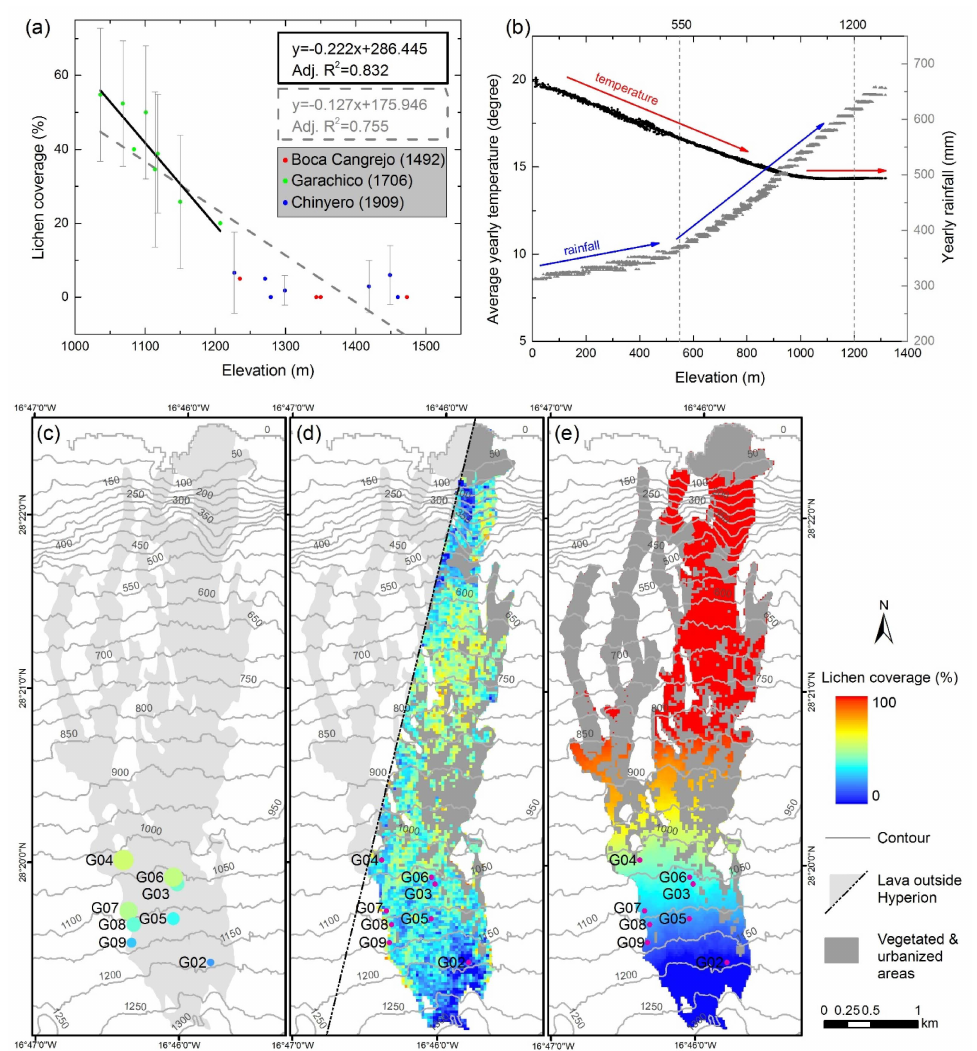
Figure 13. Lichen colonization on lava surfaces. ( a ) Relationship between field-derived spectra of lichen-covered lava sites on the Boca Cangrejo, Chinyero and Garachico lava flows and their elevations. Lichens tend to grow more at elevations <1200 m a.s.l. The black solid fitting line is plotted only for the Garachico sites and the grey dashed line is fitted to all the displayed sites; ( b ) Scatterplot of elevation vs. temperature and rainfall for the Garachico lava flow area. The temperature and rainfall maps were obtained from the Spanish Meteorological Agency (AEMET) [34]; ( c ) Lichen coverage observed in the field displayed with their point size and color representing the value of lichen coverage on the lava surface; ( d ) Lichen coverage derived from the calibrated Hyperion lichen index (Figure 12); ( e ) Lichen coverage based on the relationship between lichen coverage and elevation found in Figure 13a (the linear regression model only with the Garachico